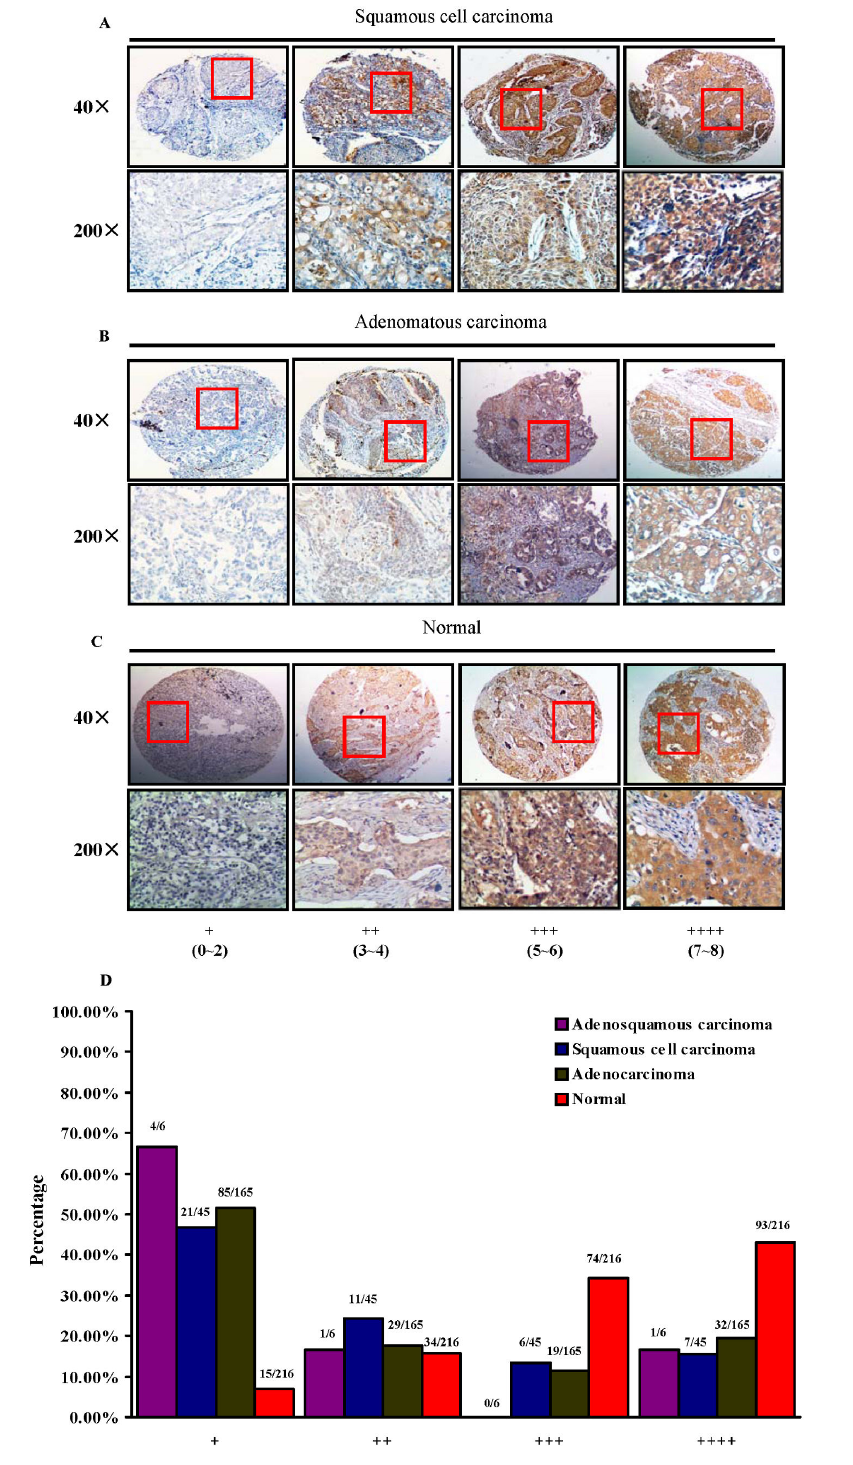
Figure 1. IHC analysis of Beclin 1 expression in human NSCLC and normal adjacent tissues. (A-C), NSCLC tissue arrays containing normal lung and tumor tissues were stained for Beclin 1 expression. Stained normal and tumor tissues were classified into four groups (+ to ++++) according to the staining intensity and extension of each tissue. (D), percentage of normal or tumor tissues in each staining group. Tissue samples with different staining intensity and extension were grouped and tabulated. doi: 10.1371/journal.pone.0080338.g001 PLOS ONE |